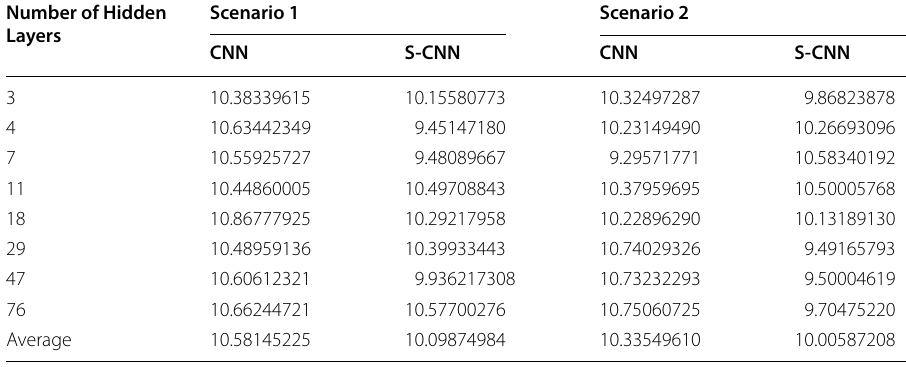
0.57) in all scenarios =